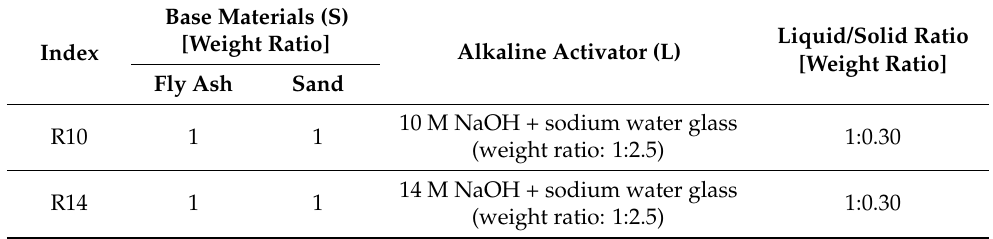
Table 7. Compositions of geopolymer mixture of the Belchatów lignite fly ash.